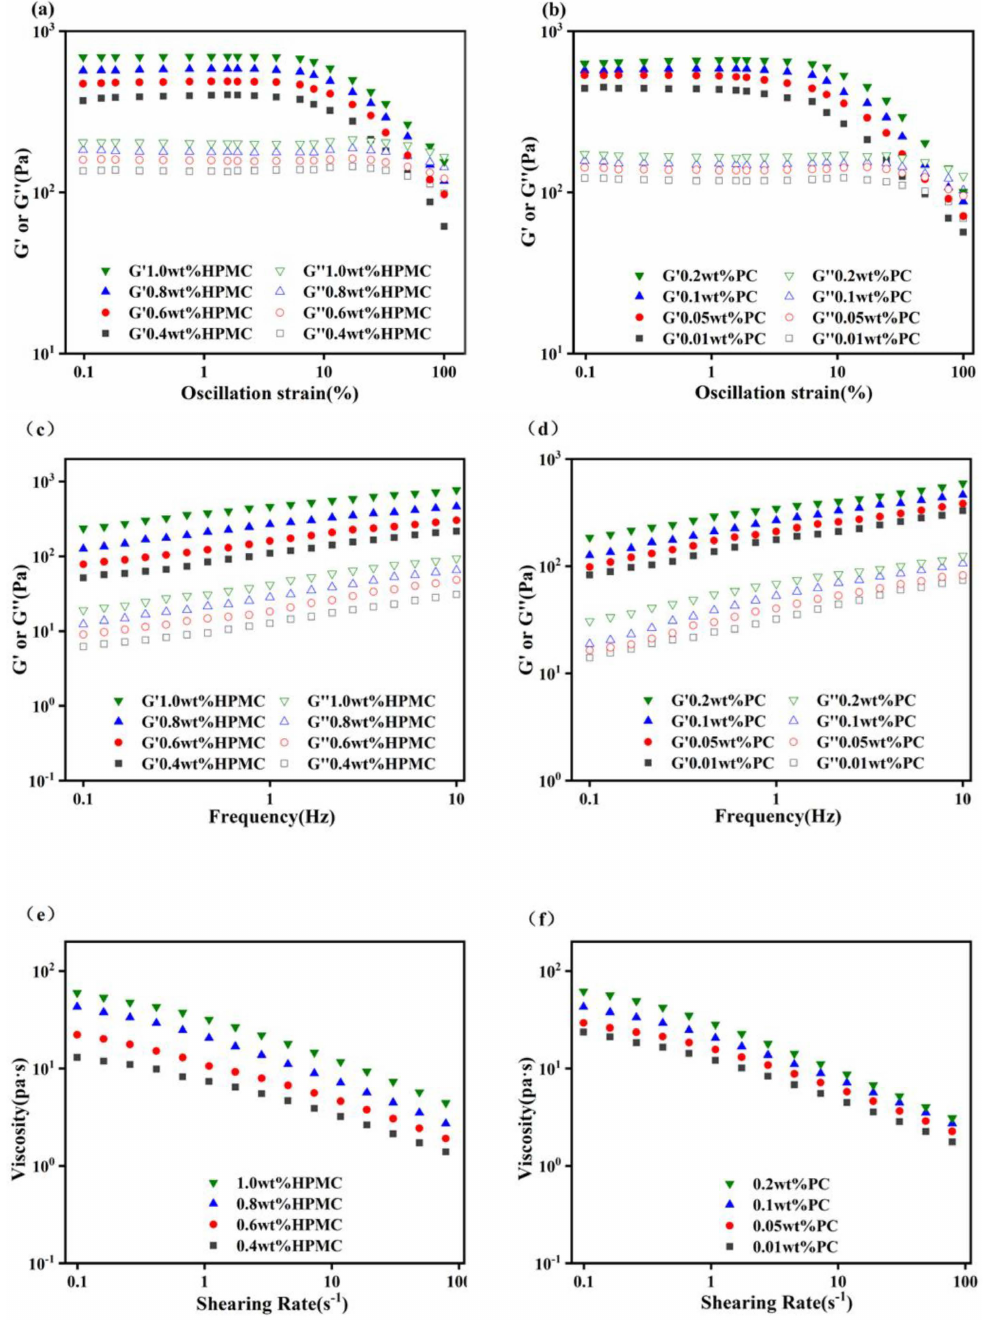
Figure 3. Amplitude sweep ( a ), frequency sweep ( c ), and flow measurement ( e ) curves for emulsions with different HPMC concentrations; a concentration of PC was kept constant at 0.1 wt%. Amplitude sweep ( b ), frequency sweep ( d ), and flow measurement ( f ) curves for emulsions with different PC concentrations; a concentration of HPMC was kept constant at 0.8 wt%. (HPMC—Hydroxypropyl methylcellulose,